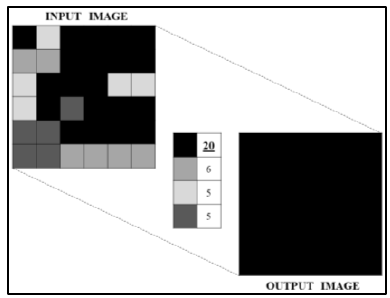
Figure 3. "Thematic Pixel Aggregation" process 5